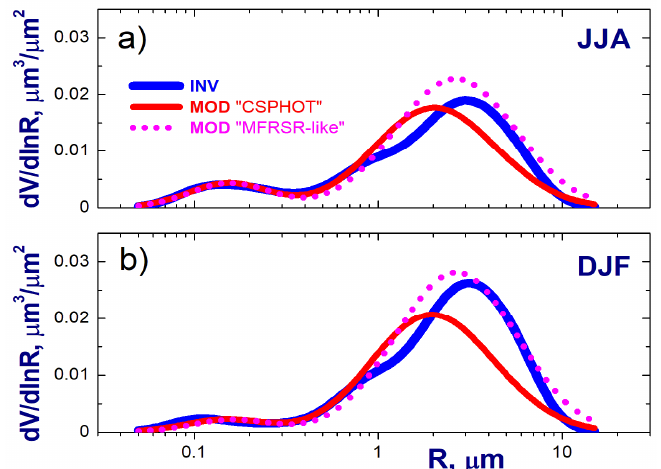
Figure 6. The volume SDs offered by the AERONET aerosol inversions (symbol “INV”) and estimated (symbol “MOD”) from AOD measured at four CSPHOT wavelengths (symbol “CSPHOT”) and AOD obtained at five “MFRSR-like” wavelengths (symbol “MFRSR-like”) for summer ( a ) and winter ( b ).